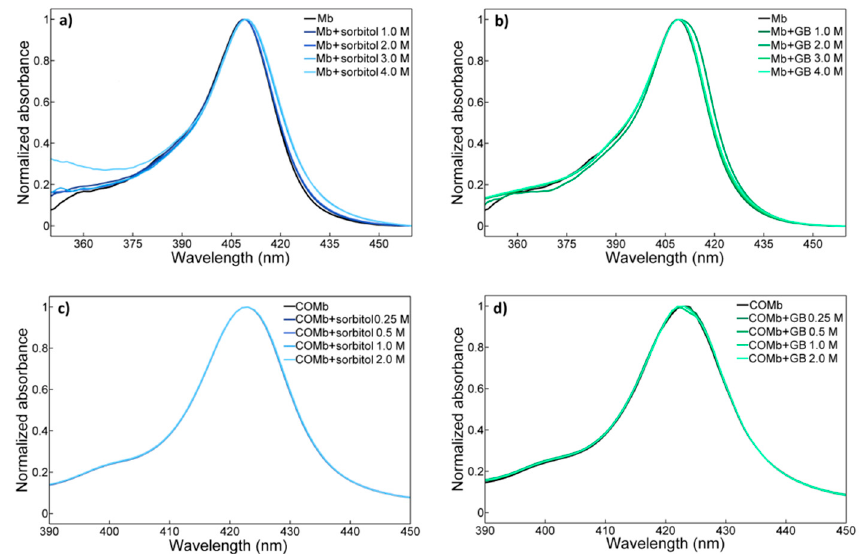
Figure 1. Concentration dependent UV-vis spectra of ( a ) metmyoglobin in the sorbitol solutions, ( b ) metmyoglobin in the glycine betaine solutions, ( c ) carbonmonoxy-myoglobin in the sorbitol solutions, and ( d ) carbonmonoxy-myoglobin in the glycine betaine solutions.